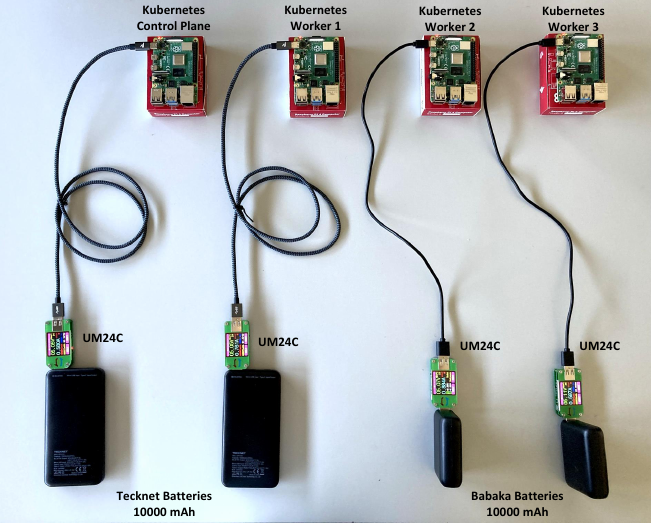
Figure 3. SBC cluster using Raspberry Pi devices with Kubernetes running on top of them.